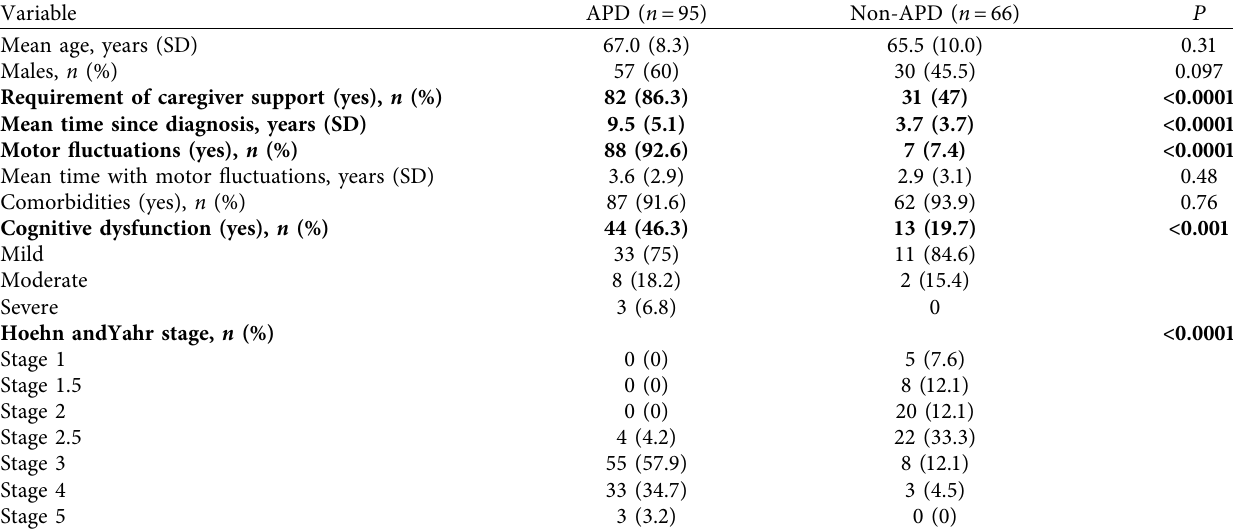
Table 2: Demographics and disease-related characteristics.